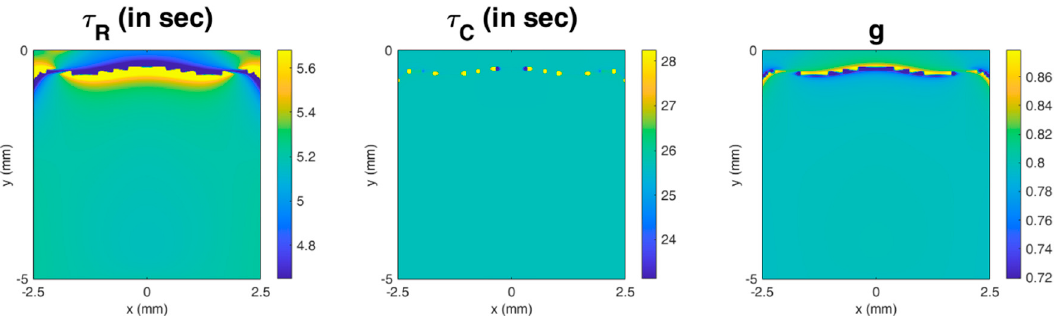
Figure 6. The image for each parameter in a case (the modulus of elasticity = 10 kPa, τ R = 5 s, and g = 0.8). It can be observed that the image for each parameter is relatively homogeneous, except for the region near the top surface of the material. Table 1. Comparison between the values of properties set in ABAQUS and the ones obtained from the simulation.